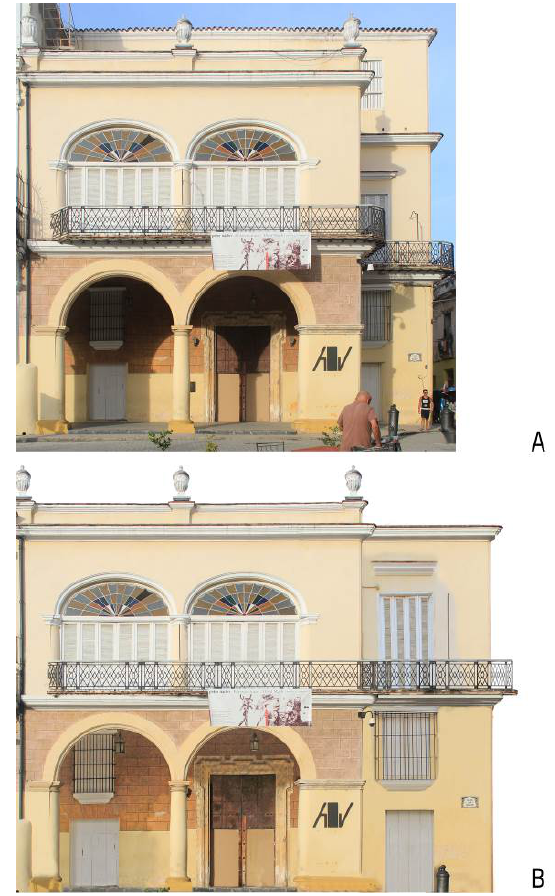
Figure 8. Comparison of photo rectification (A) with the orthophoto map (B) of a building in Plaza Vieja